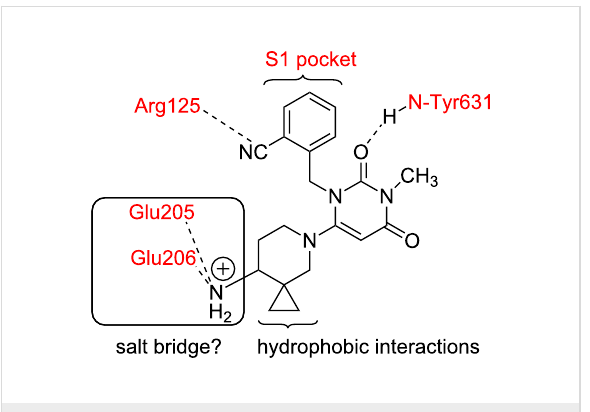
Figure 3: Predicted interactions of compound C with